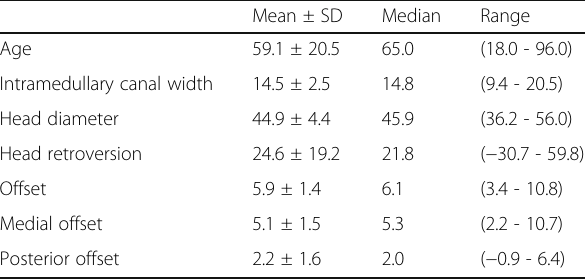
Table 2 Patient characteristics and principal humeral morphometric